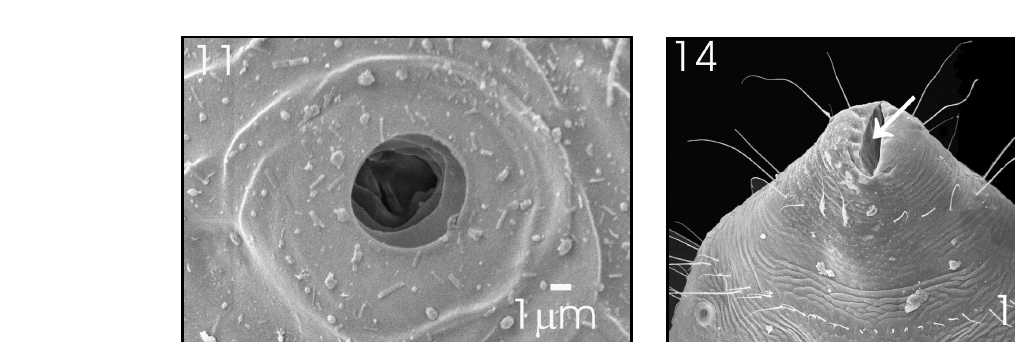
Fig. 11. A large thoracic spiracles was situated later- ally on each side of the pro-thorax.